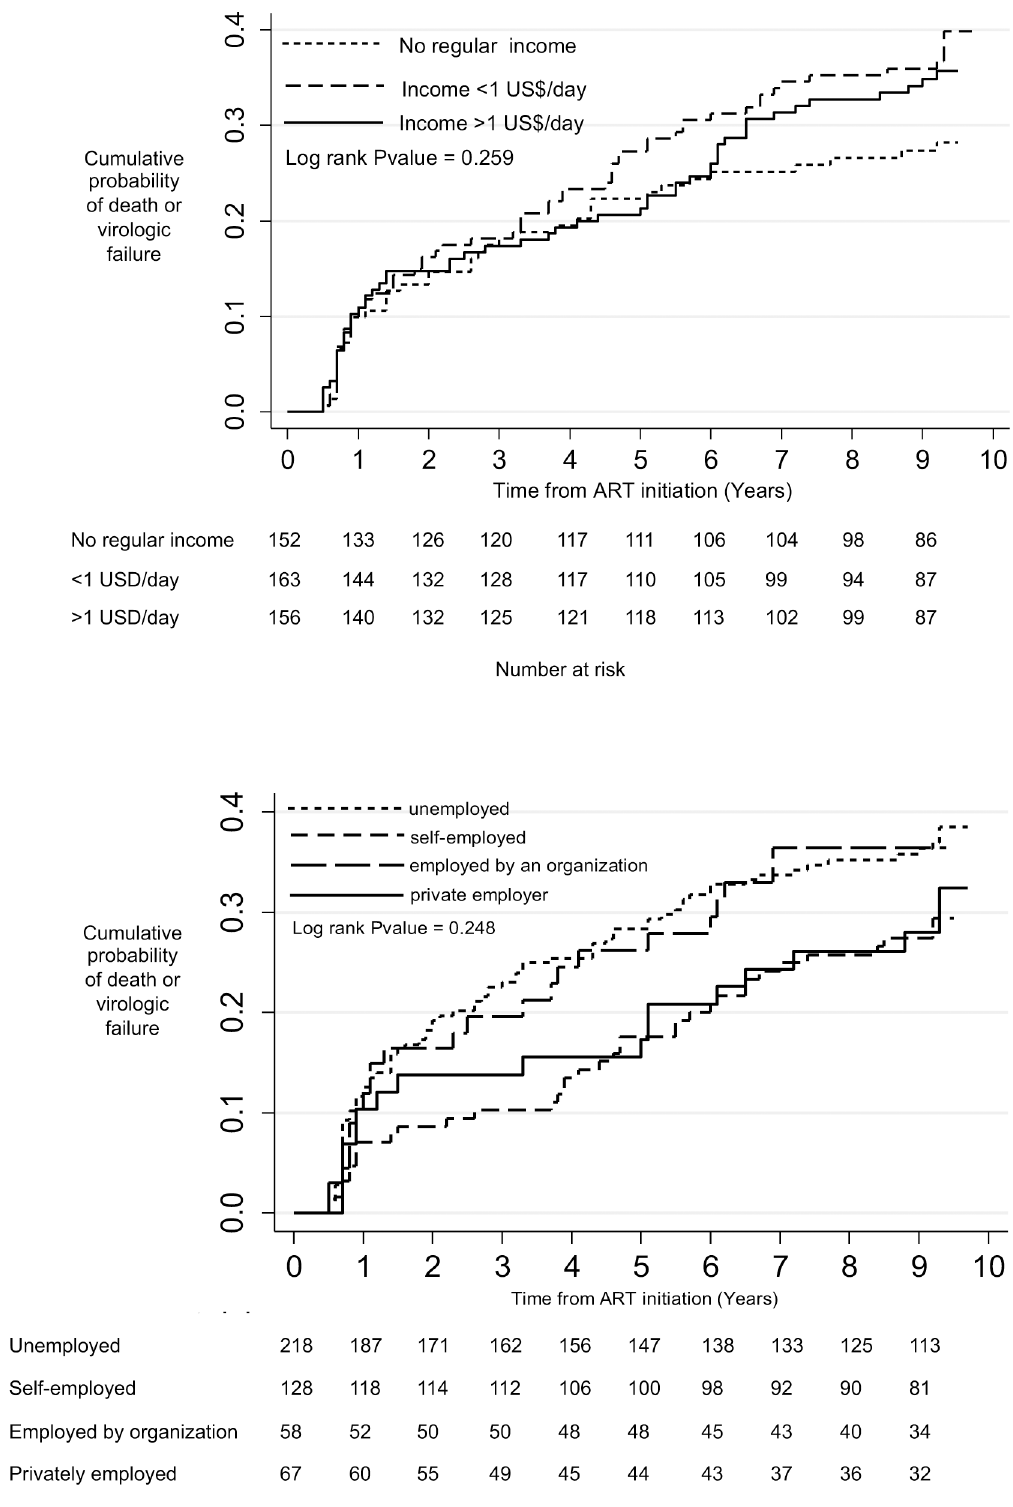
Fig 1. Death or virologic failure among HIV-infected participants surviving more than six months on ART grouped by household income and by participant employment status (N = 472). Caption:Fig 1A shows a trend